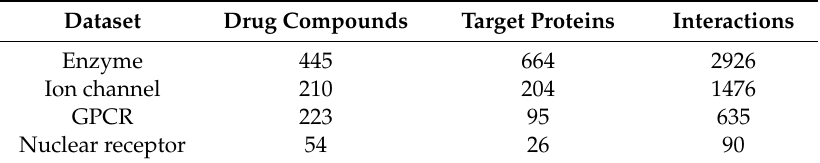
Table 7. The number of four drug-target interaction